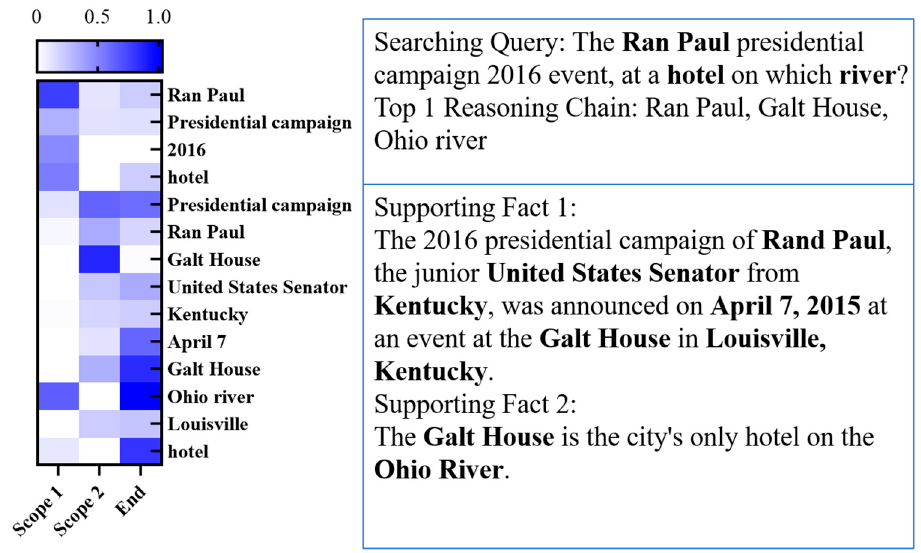
Figure 5. A case study of the development set. The number on the left side shows the importance scores of the predicted sub-scope. The text on the right side includes queries, predicted top-1 reasoning chains, and supporting facts.